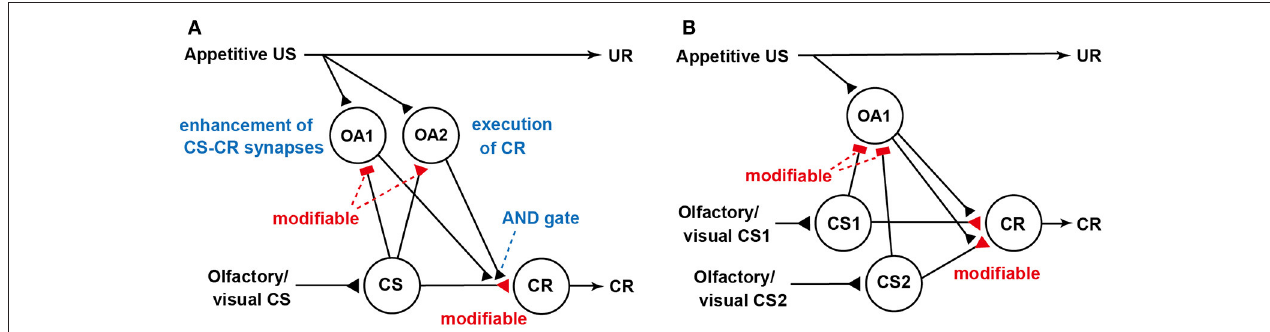
FIGURE 2 | Our updated model of the roles of octopamine neurons in appetitive conditioning. (A) Our updated model of classical conditioning established by modifying our previous model ( Figure 1B ) to match the prediction error theory (Terao et al., 2015). The model retains basic feature of the S-R and S-S hybrid model but assumes the presence of two classes of octopamine neurons, namely, “OA1” neurons that govern enhancement of “CS-CR” synapses (but not execution of a CR) and “OA2” neurons that govern execution of a CR or memory retrieval (but not a conditioning process). OA2 neurons, but not OA1 neurons, govern the “AND gate”. In this figure, we focus on the roles of “OA1” neurons: “OA2” neurons are not illustrated for simplicity. We assume that “OA1” neurons receive no or very weak inhibitory synaptic input from “CS” neurons before training and that the efficacy of the inhibitory synapses is strengthened by CS-US pairing in training. During training, “OA1” neurons receive excitatory synaptic input (triangle) representing actual US and inhibitory input (rectangle) from “CS” neurons representing “predicted US” from the CS. Thus, activities of “OA1” neurons represent US prediction errors. Synapses for which the efficacies are modifiable by CS-US pairings are shown as open rectangles or open triangles and are marked “modifiable”. (B) The model accounts for blocking and auto-blocking. In the figure, “OA2” neurons are omitted to focus on the roles of “OA1” neurons. The model assumes that pairing of a stimulus (CS1) with appetitive US leads to (1) enhancement of inhibitory pathways from “CS1” neurons to “OA1” neurons and (2) enhancement of excitatory synapses from “CS1” neurons to “CR” neurons. During pairing of a compound of CS1 and CS2 with US after sufficient repetition of CS1-US pairing trials, “OA1” neurons are inhibited by activation of “CS1” neurons and thus activation of “OA1” neurons in response to US presentation is inhibited. As a result, enhancement of “CS2-OA1” synapses and “CS2-CR”synapses, in which “CS2” neurons mediate CS2, does not occur. Therefore, no learning of CS2 occurs. The model also predicts that injection of an octopamine receptor antagonist before CS1-US conditioning trials impairs enhancement of “CS1-CR” synapses but not “CS-OA1” synapses. Therefore, no enhancement of “CS1-CR” synapses should occur in subsequent training even after recovery from the effect of the drug. We refer to this phenomenon as auto-blocking. Modified from Terao et al. (2015).